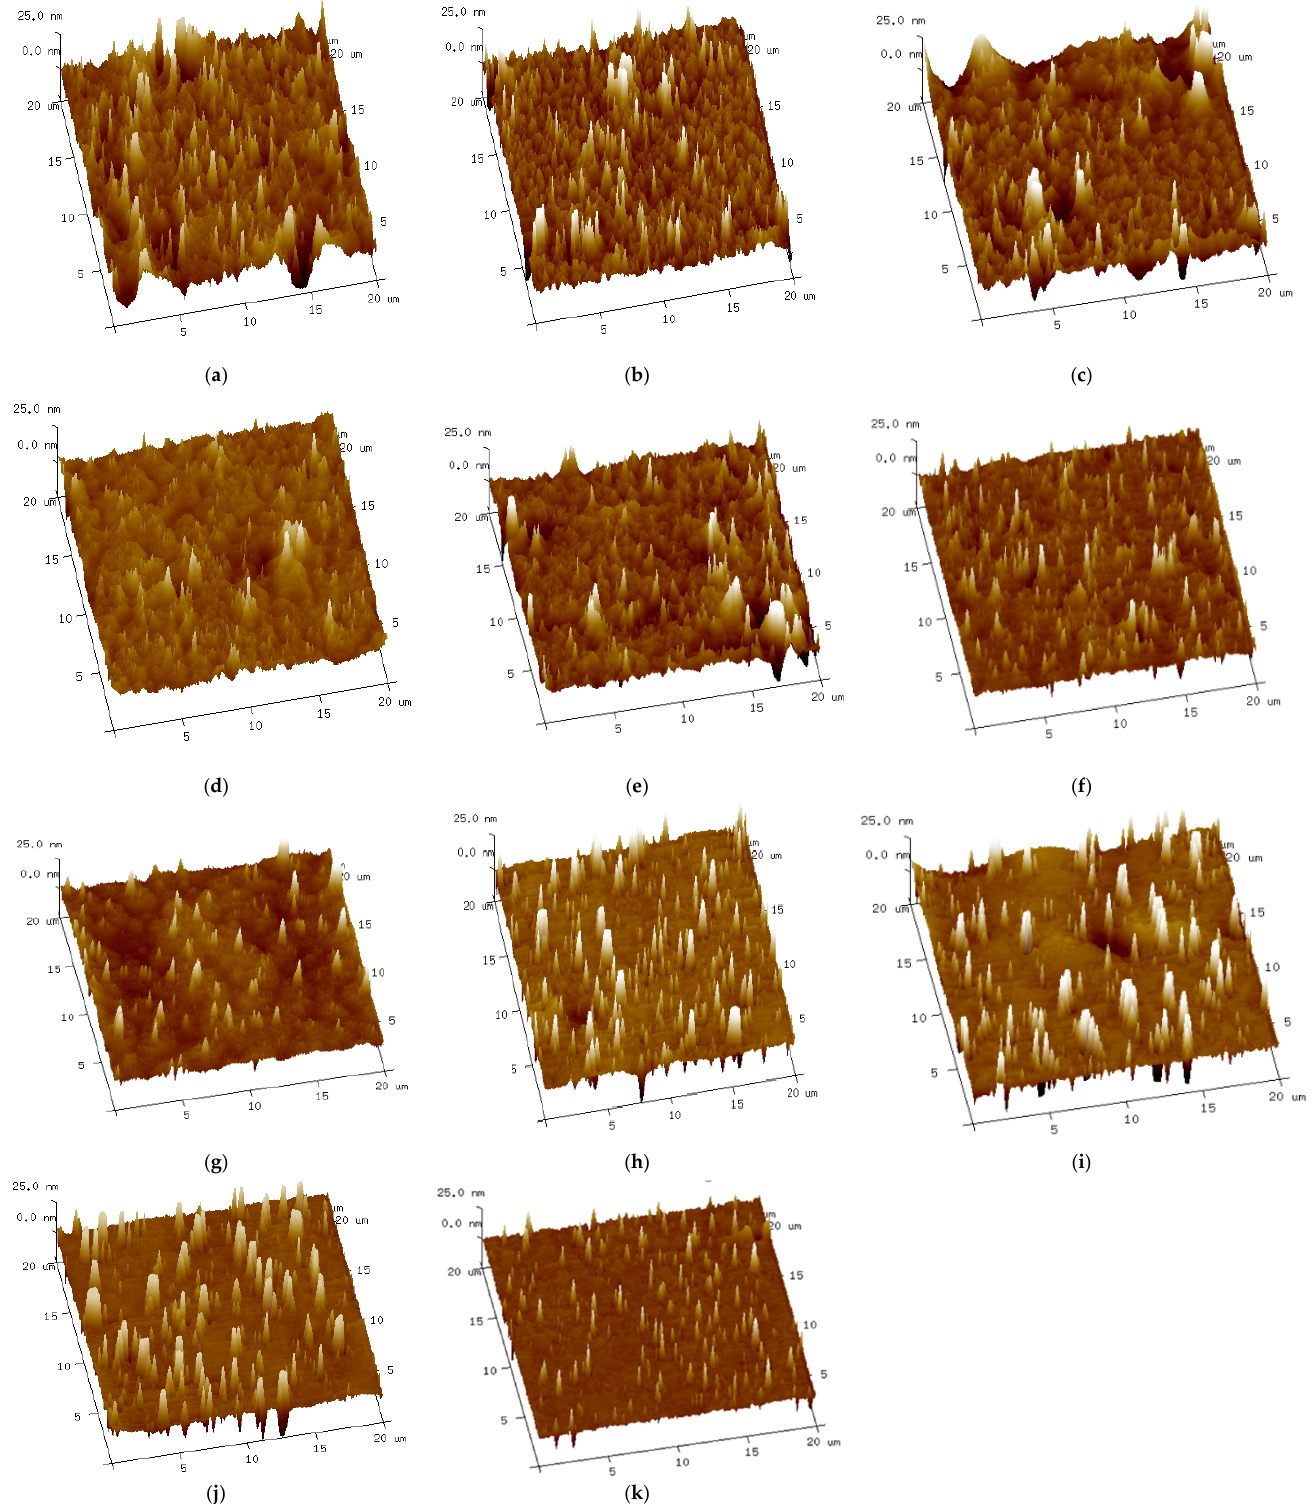
Figure 6. The 3D appearance of each aging asphalt: ( a ) aging asphalt; ( b ) 5% + 20 min; ( c ) 5% + 40 min; ( d ) 5% + 60 min; ( e ) 6% + 20 min; ( f ) 6% + 40 min; ( g ) 6% + 60 min; ( h ) 7% + 20 min; ( i ) 7% + 40 min; ( j ) 7% + 60 min; and ( k ) original asphalt.